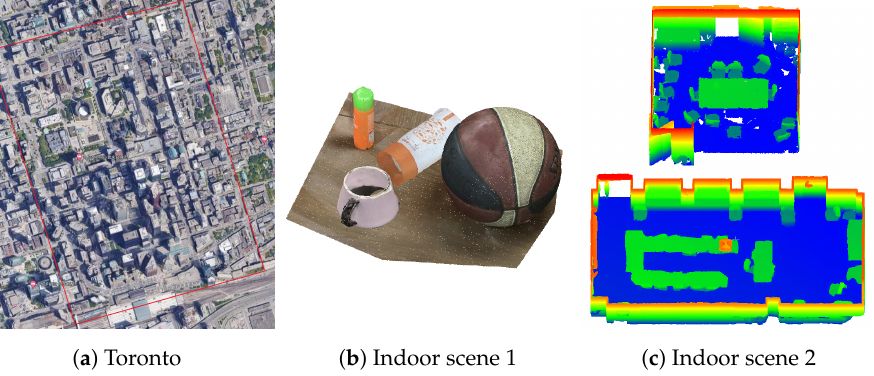
Figure 5. The introduction to the datasets: ( a ) The ISPRS benchmark data from the city of Toronto, ON, Canada; and ( b , c ) indoor scenes created by the matching of close-range